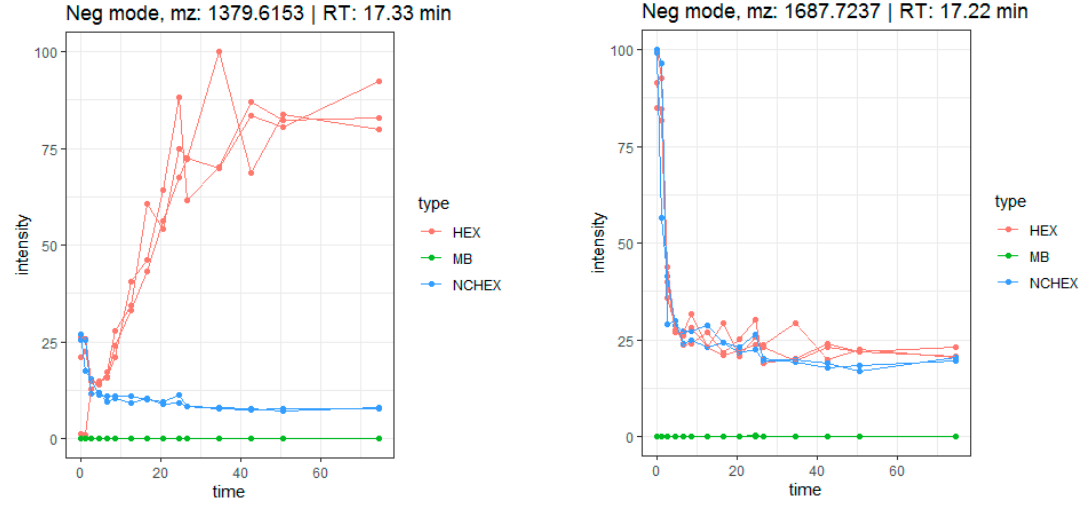
Figure 5. Time profile of the biotransformation of compounds 46 (left) and 45 (right) in samples (HEX), negative controls (NCHEX) and blank (MB).